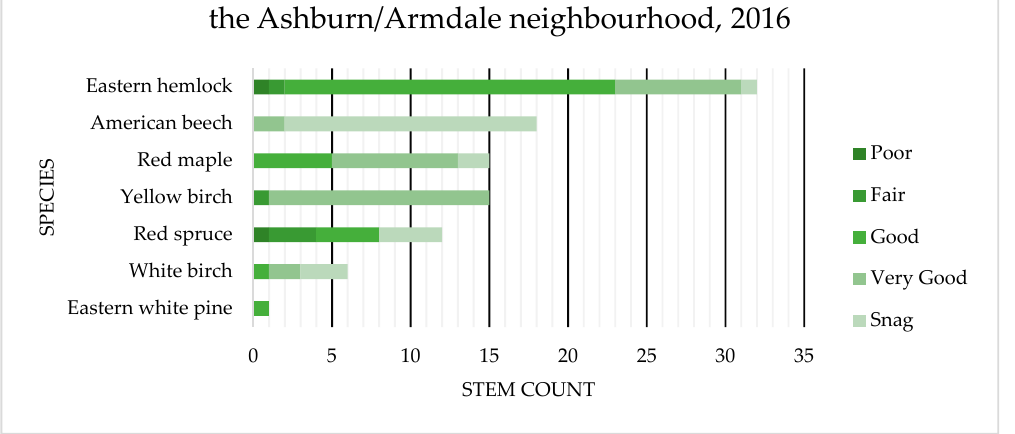
Figure 8. Crown condition of trees sampled within ingrowth areas of the Ashburn/Armdale neighborhood (adapted from source data: 11). The high proportion of snags among the American beech population suggest that disease and pest infestations have decimated the population of this foundational Acadian species.